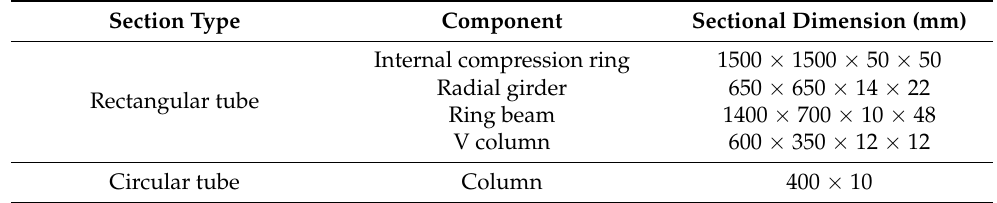
Table 1. Component